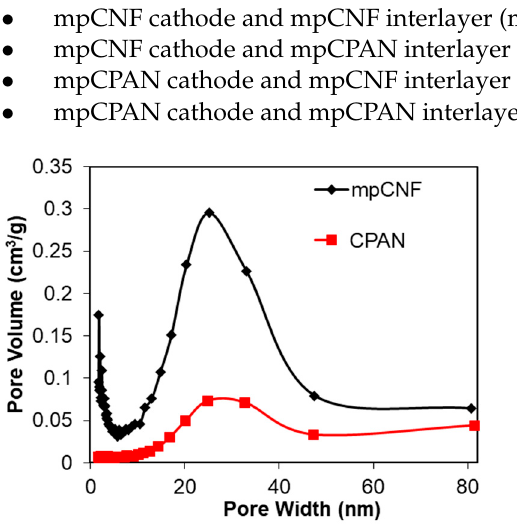
Figure 10. Comparison of pore-size distribution of mpCNF and CPAN assessed by the BET method.